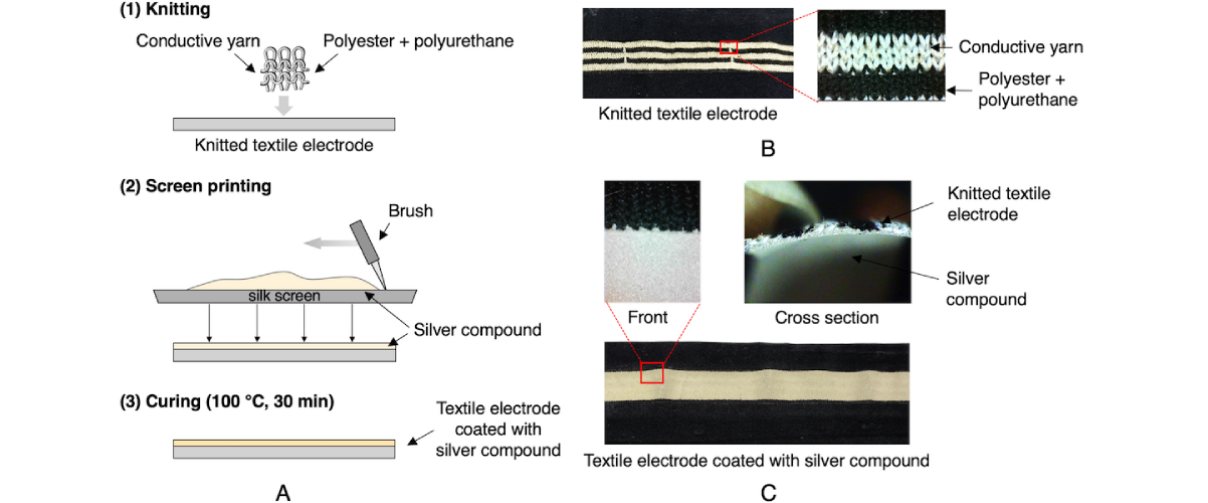
Figure 2. Fabrication process and configuration of the knitted textile electrode for electrocardiogram measurement. A. Fabrication process of the knitted